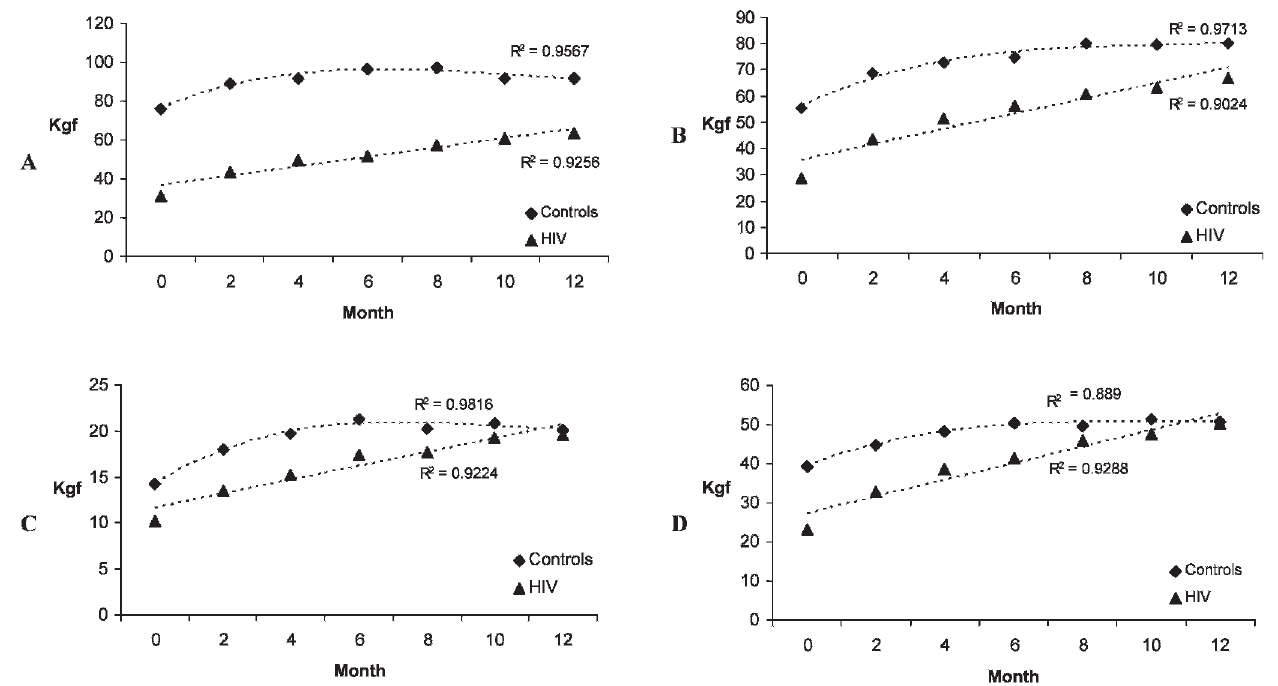
Figure. Pattern of muscular strength gain along the period of training for elderly people living with HIV and controls. A = Leg Press; B = Lumbar Extension; C = Chest Press; D = Seated